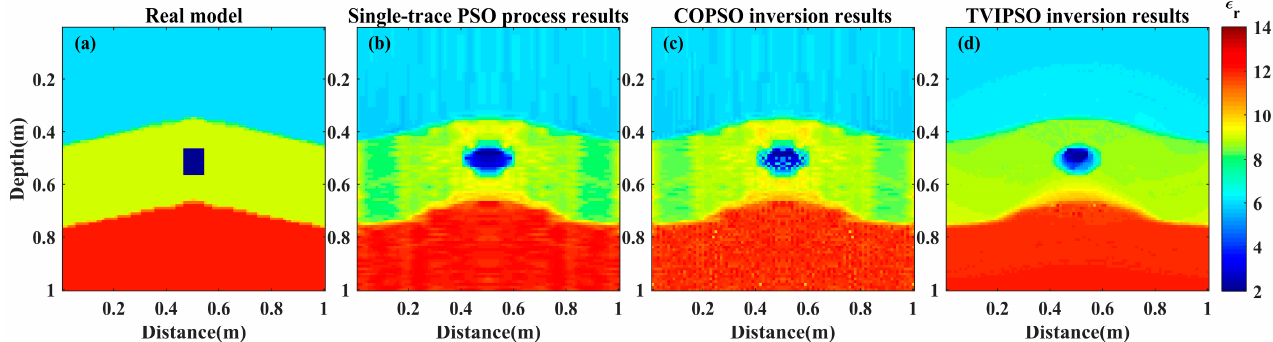
Figure 13. Permittivity inversion results: ( a ) real model; ( b ) initial model constructed using the single-trace PSO process; ( c ) COPSO inversion model; ( d ) TVIPSO inversion